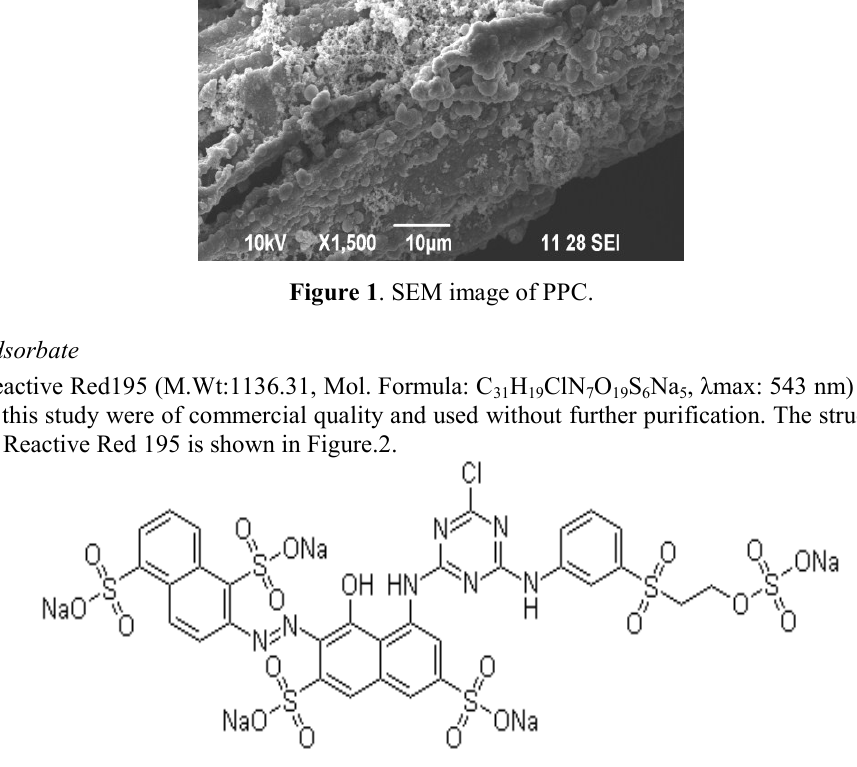
Figure 2. Structure of Reactive